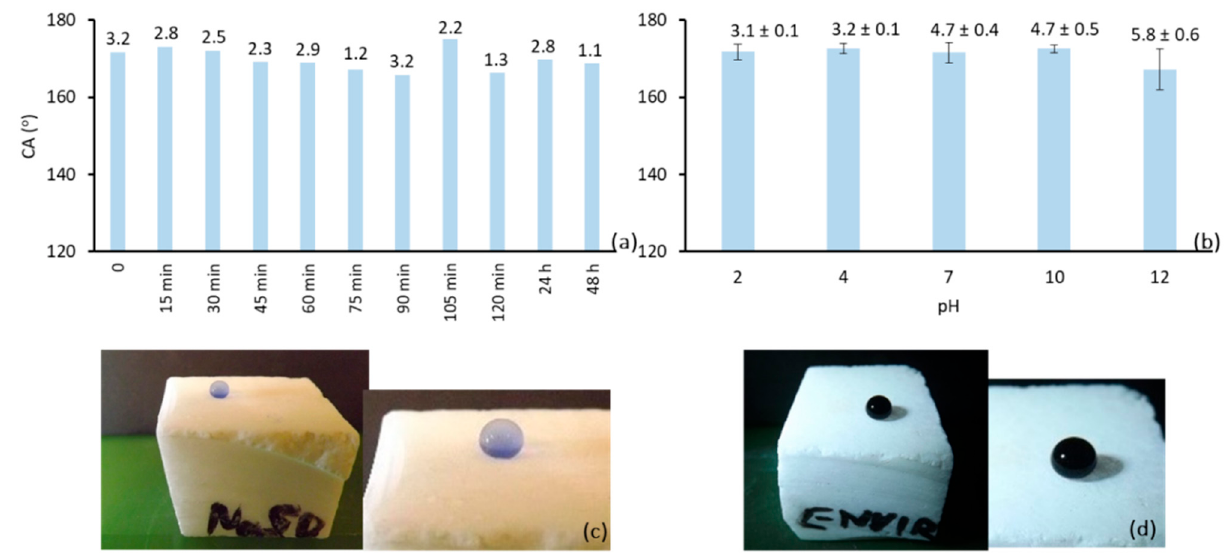
Figure 5. ( a ) The bars correspond to CA measurements of water drops on coated marbles that were previously immersed in a water bath for various time periods designated in the horizontal axis. The corresponding SA is provided at the top of each bar. ( b ) The bars correspond to CA measurements of water drops with different pHs. The corresponding SA is provided at the top of each bar. ( c ) Photographs of water drops on coated marble that was previously immersed in a saturated solution of Na 2 SO 4 . ( d ) Photographs of water drops on coated marble that was exposed to atmospheric conditions for 70 days.